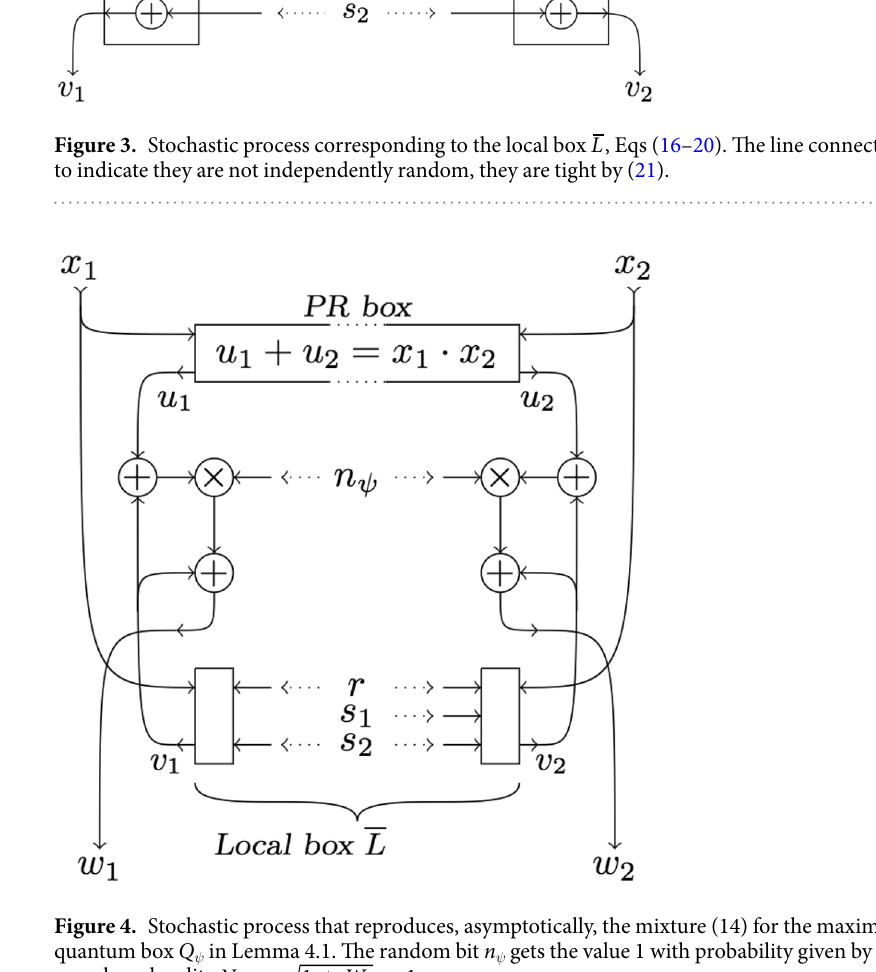
The locus of maximally nonlocal boxes lies within the 4-simplex with apex the PR box R and base the in (17)–(20) (let us denote it Δ 4 ). The projections of the locus of Q ψ 3-simplex with vertices the local boxes b s s 1 2 boxes onto each of the five facets (3-simplices) of Δ 4 are shown as the blue curves in Fig. 2. The arrows along the locus indicate the direction of increasing β . The end points of the locus of Q ψ boxes are the product boxes b 00 (when β = 0, V ψ = 1; see (21)) and b 01 (when β = π /2, V ψ = 1; see (21)), with stochastic matrices in (17) and (18). The box with the strongest causal nonlocality ( − 2 1 ) is marked with a red dot, which is reached when β = π /4. The green dot is the barycenter of the facet. All boxes Q in the 3-simplex with vertices { b ij } are local, with the biggest Bell correlation [ Q ] = 2 for a local box. In this facet of local boxes the barycenter and the projection of the box with the strongest nonlocality coincide. Maximally Nonlocal Boxes as Stochastic Processes The no-signaling boxes and the associated average measure of causal nonlocality (10) have, by definition, a direct interpretation as a set of stochastic processes that simulate quantum correlations without using classical forms of communication between the parties.